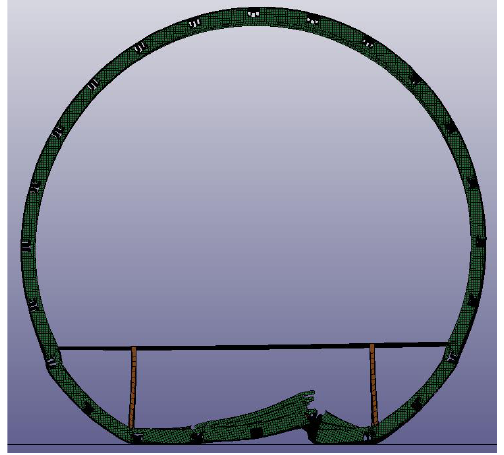
Figure 7: Glass/Epoxy skin fuselage Figure 8: Graphite/Epoxy skin fuselage